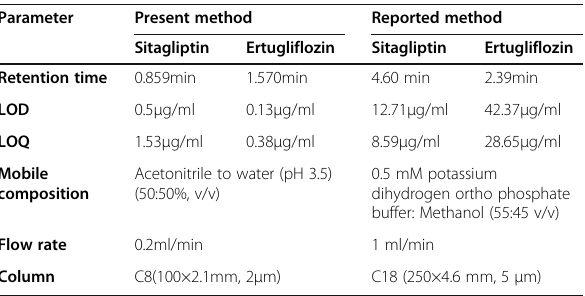
Table 10 Comparison between the present method with the reported method